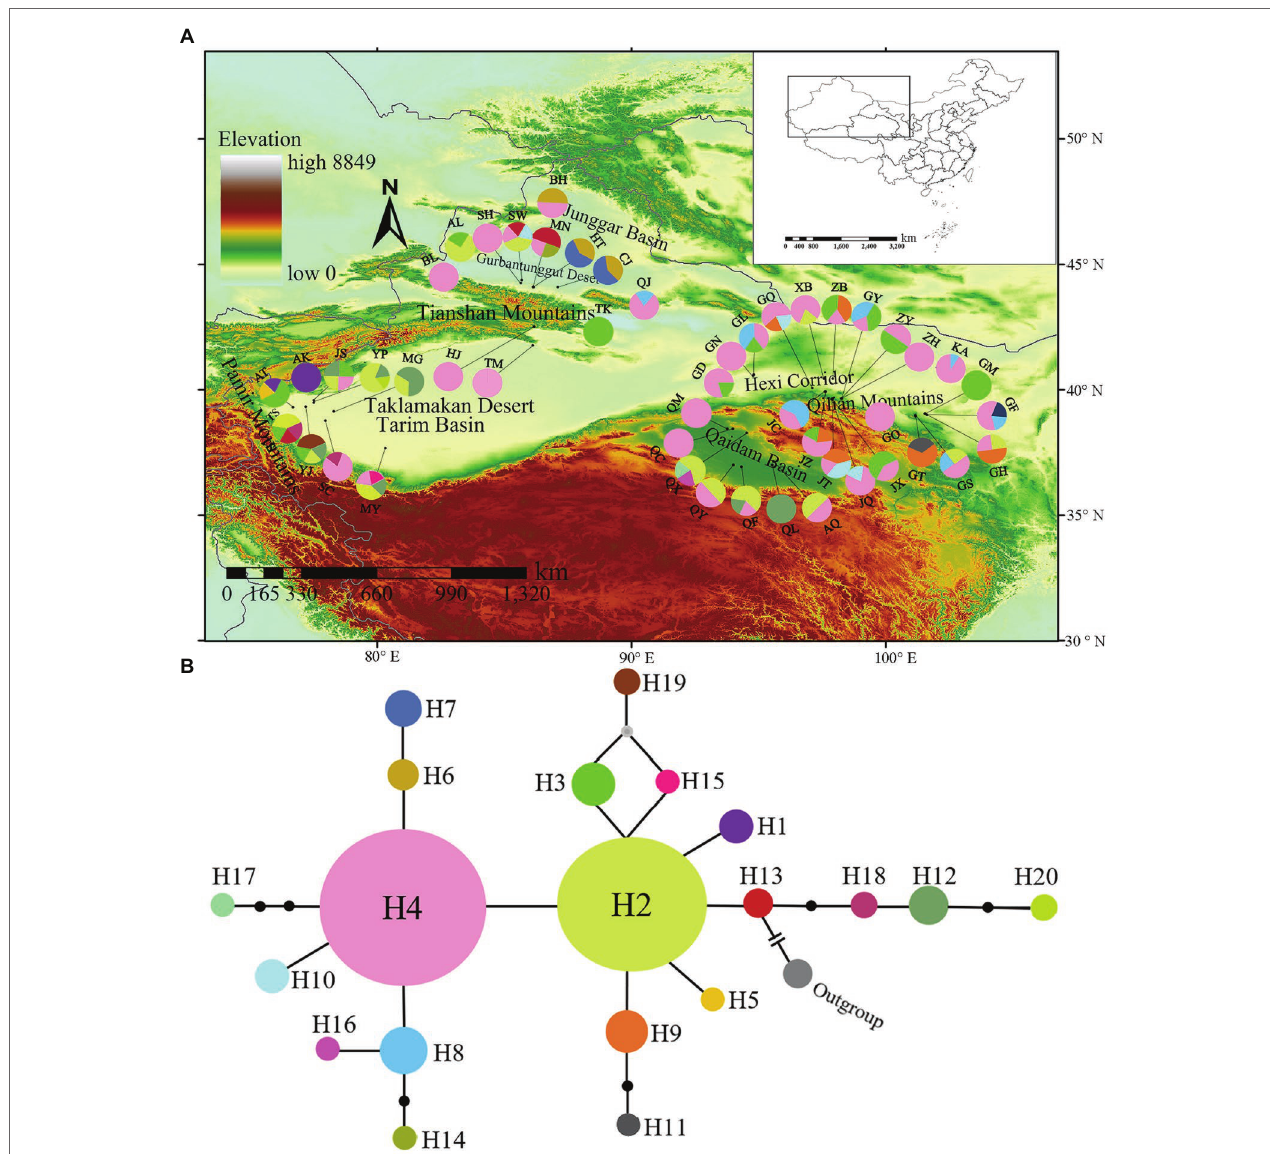
FIGURE 2 | Analysis of cpDNA fragment ( rps16 – trnK and trnH – psbA ) haplotypes of Lycium ruthenicum . (A) Geographical distributions of cpDNA haplotypes. (B) Statistical parsimony network of cpDNA haplotypes. Circle sizes are roughly proportional to individual numbers ( n ) of haplotypes. Smallest circles represent n = 1 while largest circles represent n = 88. Solid lines represent mutational steps interconnecting two haplotypes. Each line represents 1 step.